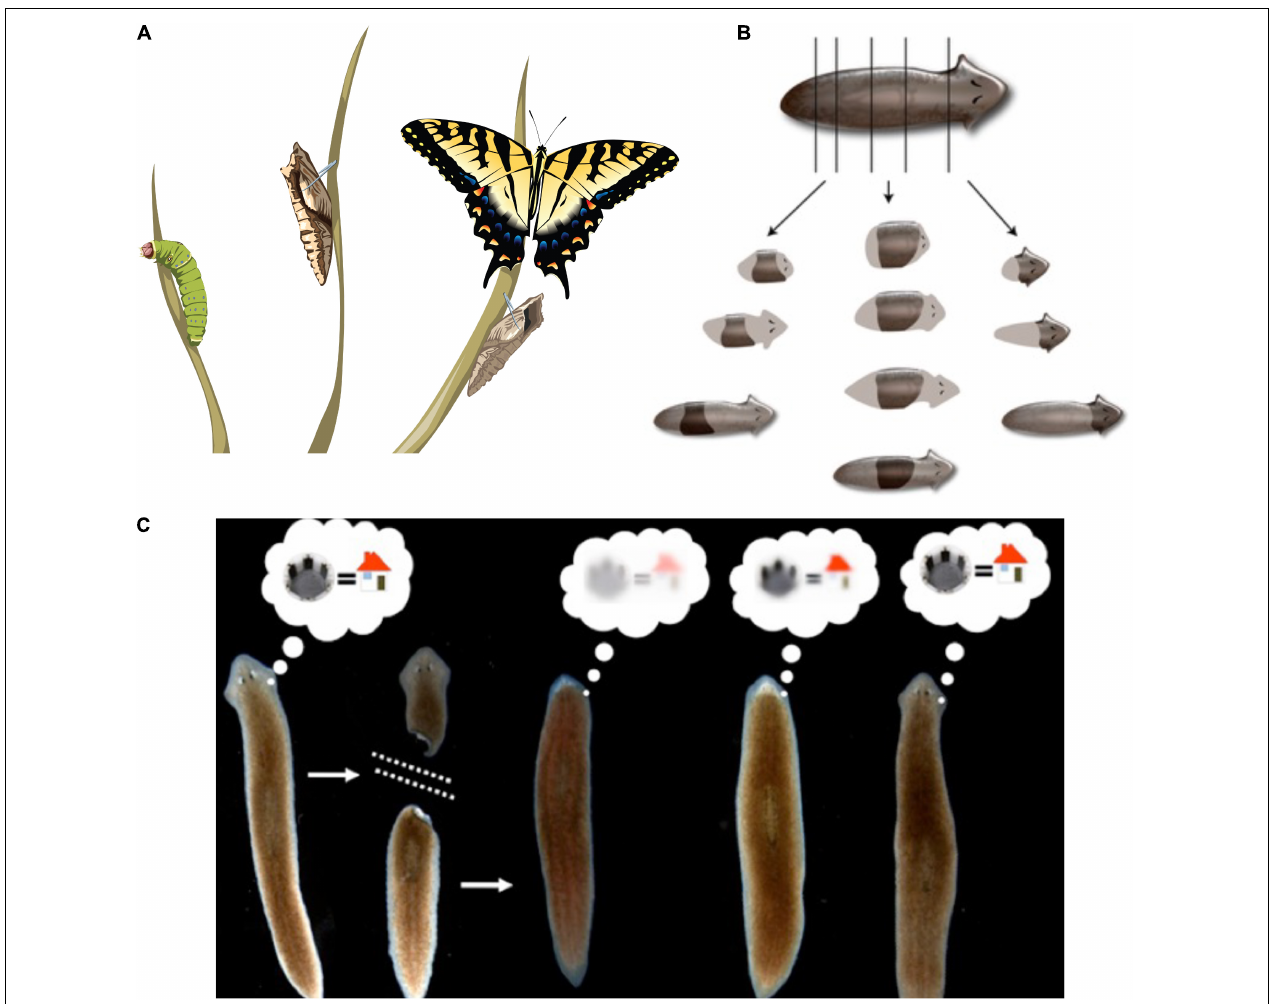
FIGURE 3 | Cognitive Selves can change in real-time. (A) Caterpillars metamorphose into butterflies, going through a process in which their body, brain, and cognitive systems are drastically remodeled during the lifetime of a single agent. Importantly, memories remain and persist through this process (Blackiston et al., 2015). (B) Planaria cut into pieces regenerate, with each piece re-growing and remodeling precisely what is needed to form an entire animal. (C) Planarians derived from tail fragments of trained worms still retain original information, illustrating the ability of memories to move across tissues and be reimprinted on